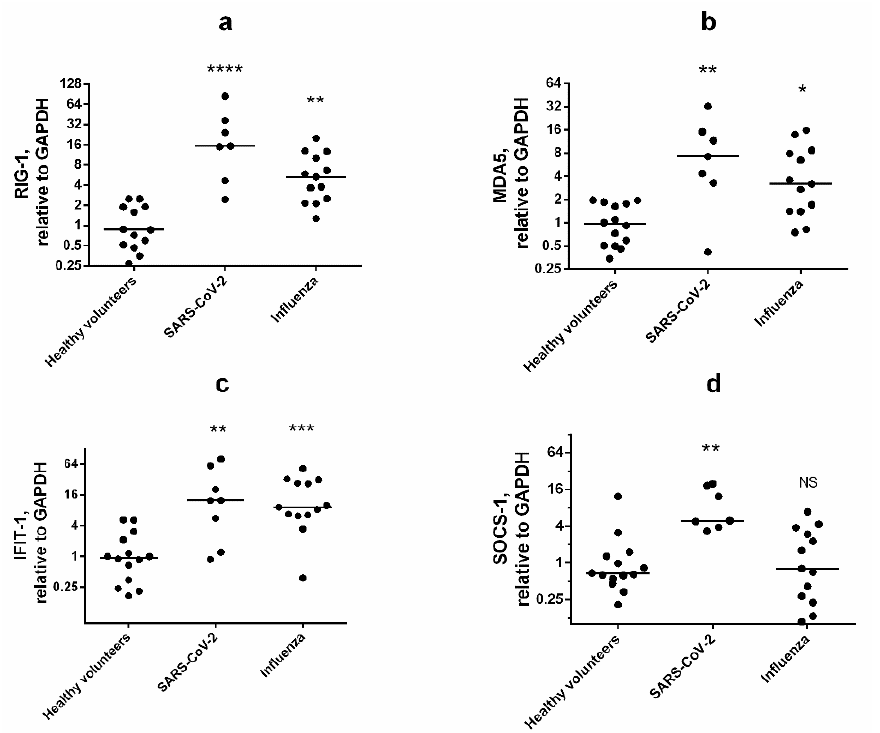
Figure 4. IAV and SARS-Cov-2 are potent inducers of RIG-1, MDA5, and IFIT-1 expression in WBCs. Gene expression of RIG-1 ( a ), MDA5 ( b ), IFIT-1 ( c ), and SOCS-1 was analyzed via the ΔΔ Ct method (relative to GAPDH). Statistical significance ( p -value) was determined by Kruskal–Wallis test, followed by Dunn’s multiple comparisons test; NS—no significant difference; ****—adjusted p Value < 0.0001; ***—< 0.001; **—<0.01; *—<0.05 compared to healthy volunteers. Data are repre-